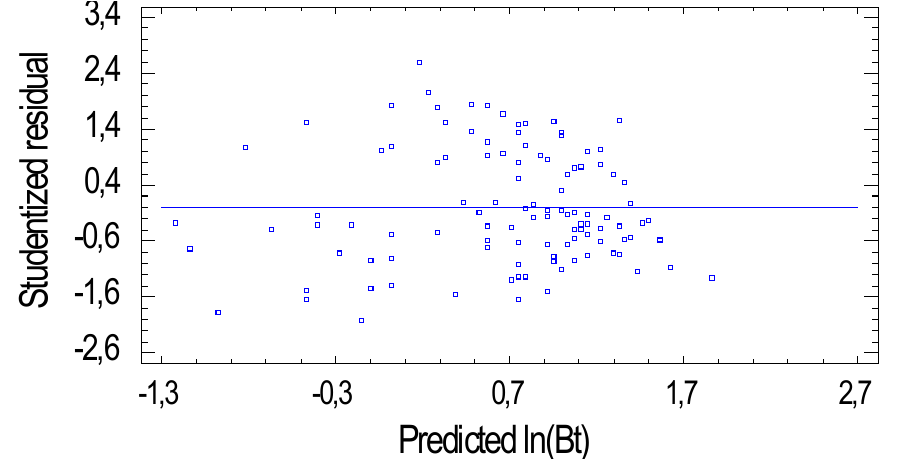
Figure 5. Plot of the studentized residuals against predicted values for the selected model (Equation (1) log-transformed): ln( Bt ) = − 4.462 + 2.784ln( Db ); original units are in kilograms of dry mass.